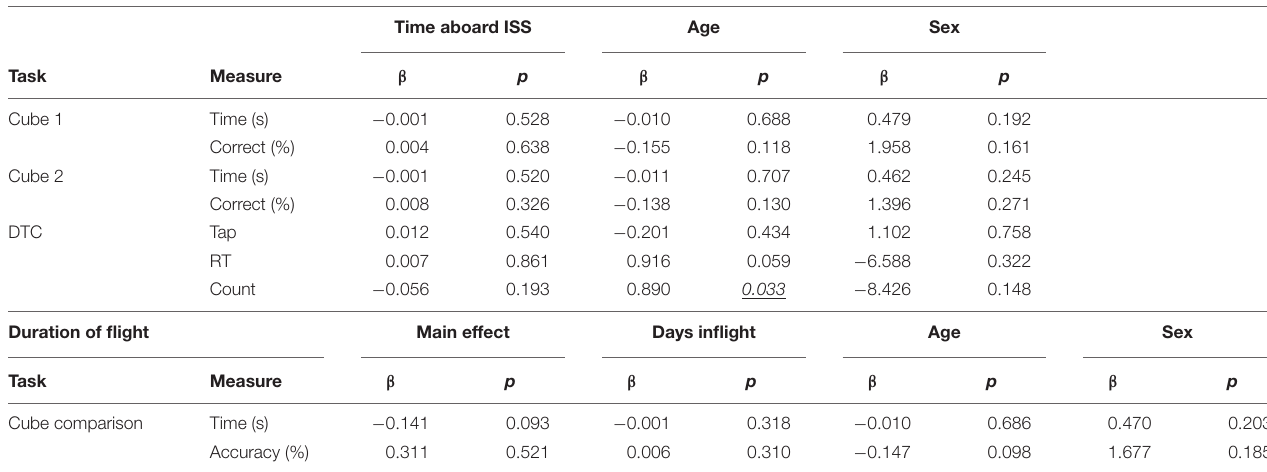
TABLE 6 | Effects of duration aboard the